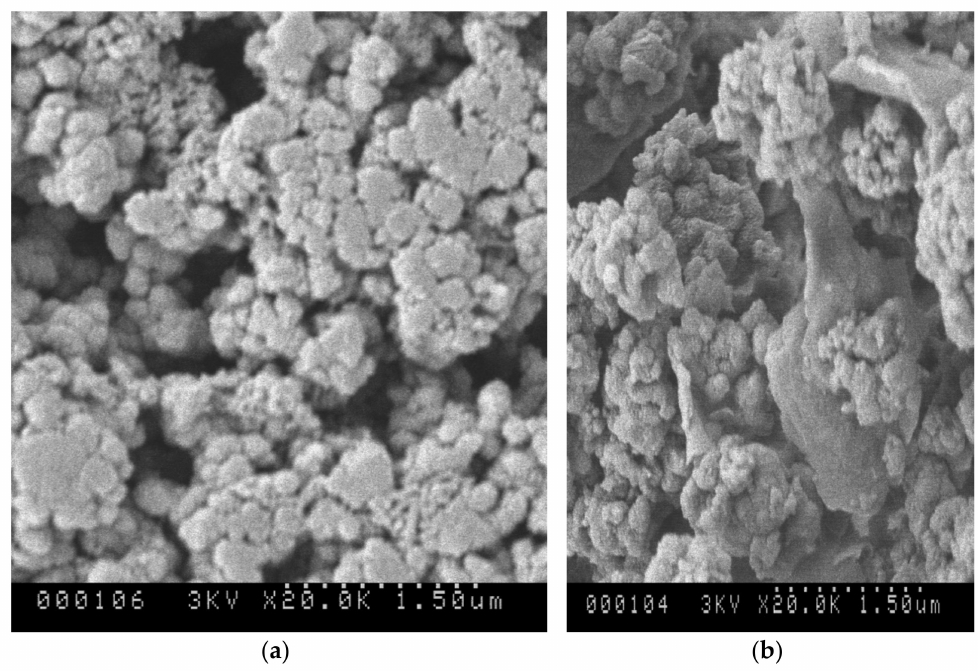
Figure 9. SEM micrographs of PACN–CSA ( a ) and mechanically mixed PANi–CSA and CLOISITE ® 20 A clay ( b